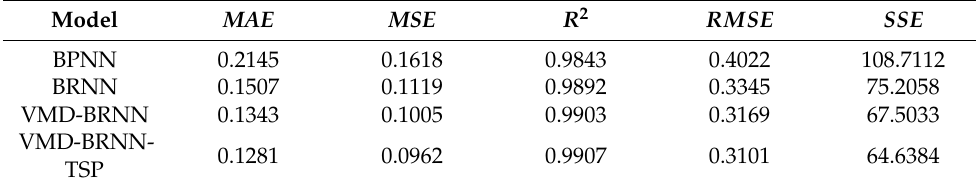
Table 3. Error values